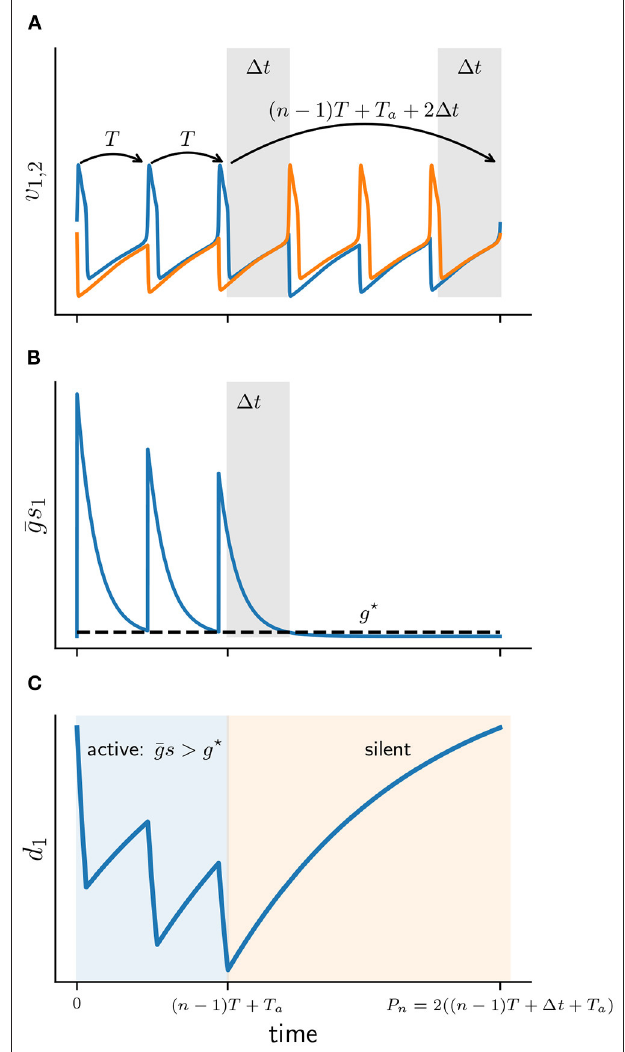
FIGURE 5 | Schematic diagram of the active and silent phases for a 3 : 3 solution. (A) Membrane potentials of cell 1 ( v 1 blue) and cell 2 ( v 2 orange). Gray patches depict 1 t intervals. (B) Total synaptic conductance of cell 1 ( ¯ gs 1 ) as it crosses the release conductance g ⋆ . (C) Solution d 1 ( t ) of depression variable of cell 1, during active (blue) and silent phases